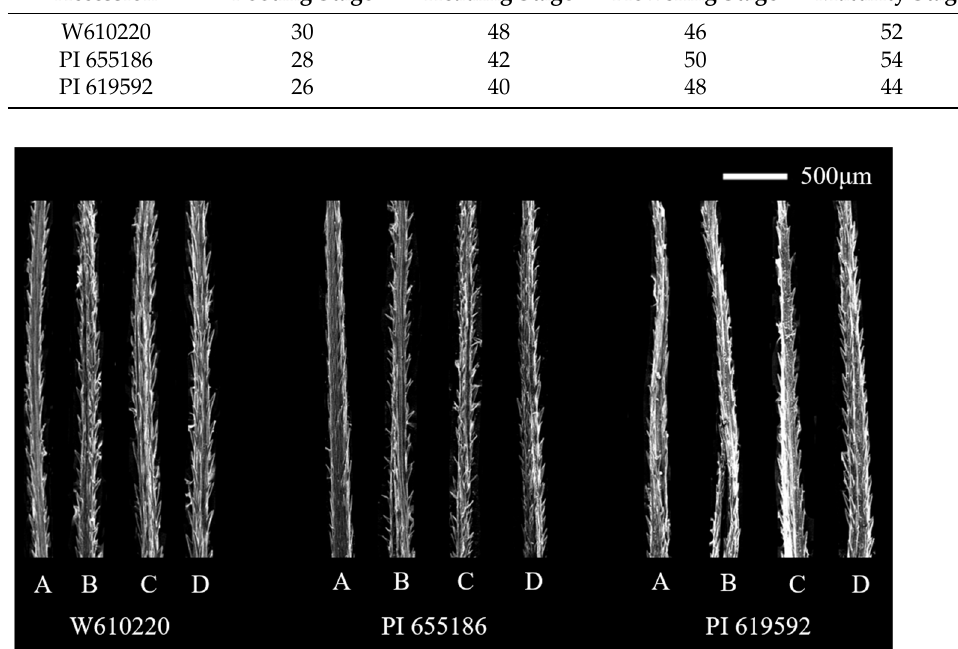
Figure 1. The images of the middle part of awns for three accessions at four developmental stages: (A) booting stage; (B) heading stage; (C) flowering stage; and (D) mature stage. W610220, long awn, PI 655186, medium awn, PI 619592, short awn.